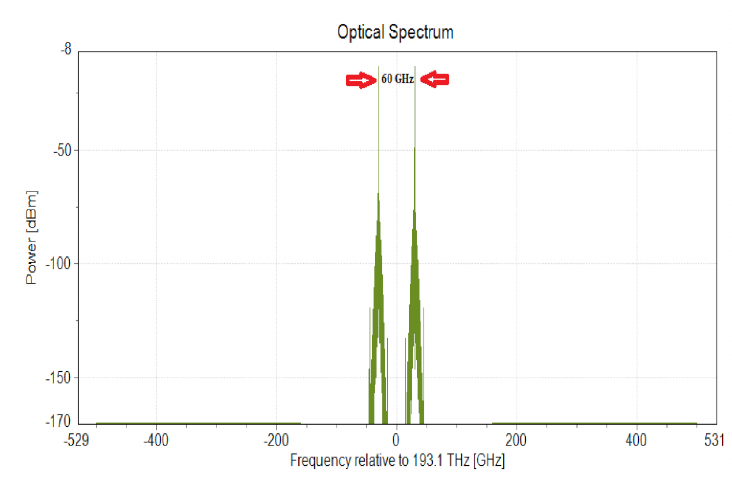
Figure 6. Spectrum obtained after the selection of mm-wave frequency (60 GHz) sidebands by a bus selector module from different sidebands.